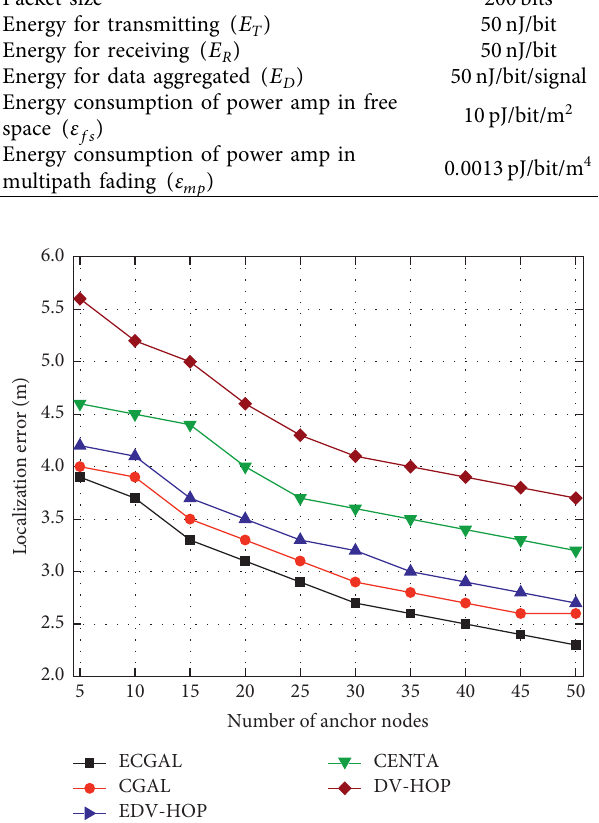
Figure 10: Localization error against the number of anchor